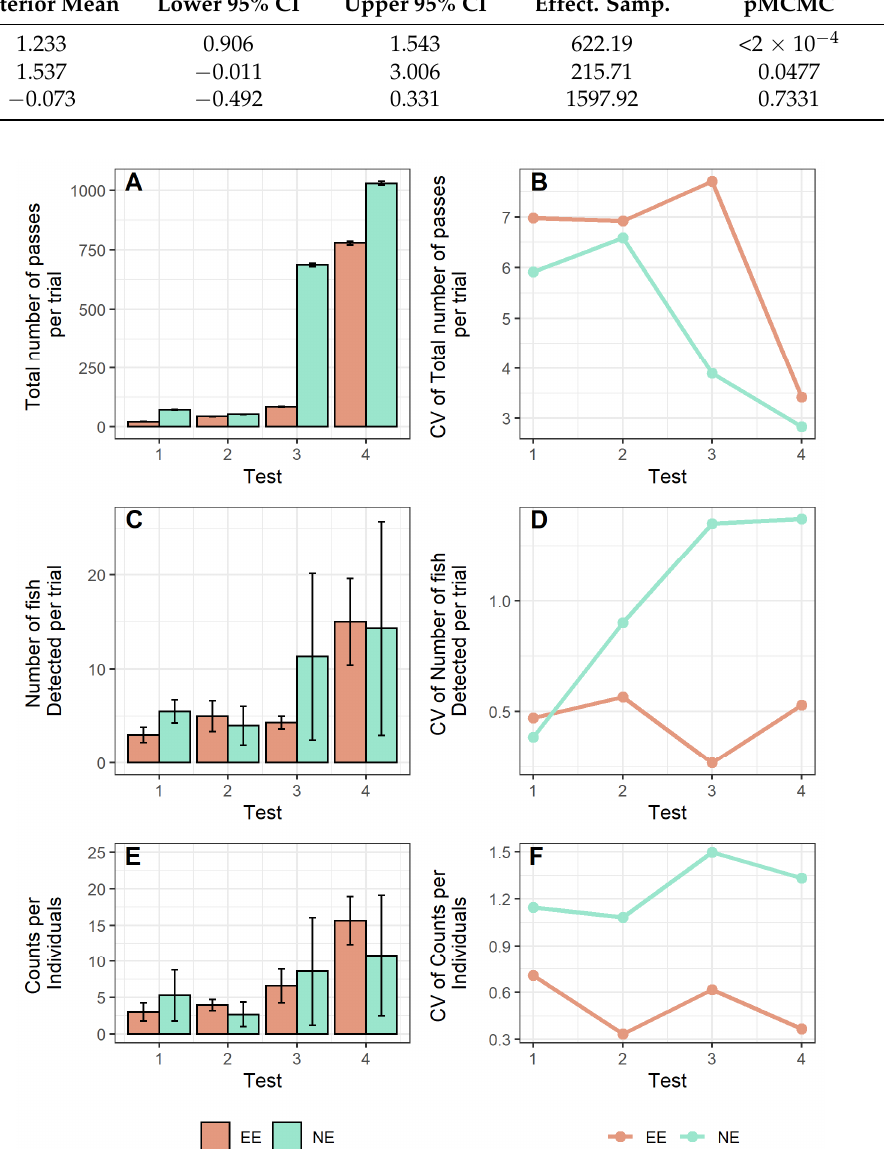
Table 1. Resulting posterior mean, lower and upper 95% credibility intervals (CIs), effective sample size (out of 4990), pMCMC (MCMC p -value), and significance (asterisks) from the developed model. Posterior Mean Lower 95% CI Upper 95% CI Effect. Samp. pMCMC Signif.